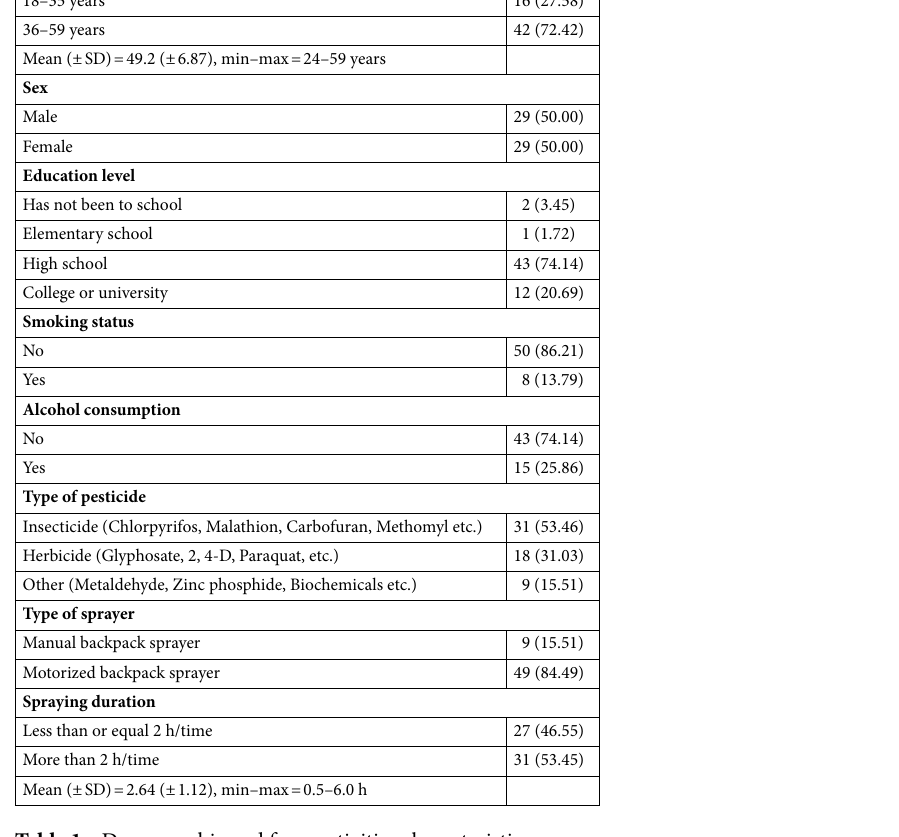
Table 1. Demographic and farm activities